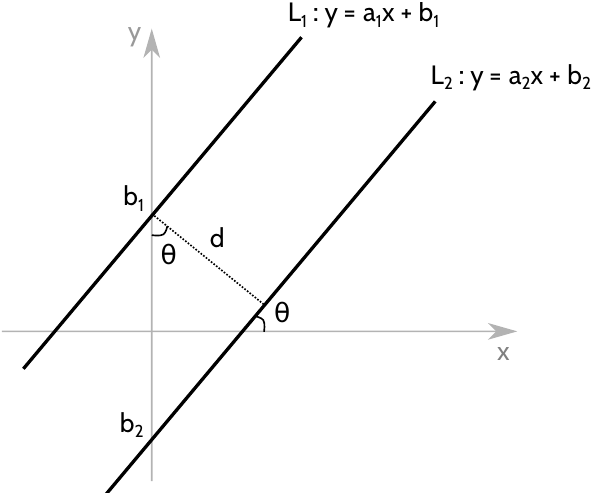
Figure 6. Computing the distance between two parallel models L 1 and L 2 . Note that a 1 = a 2 for the models to be